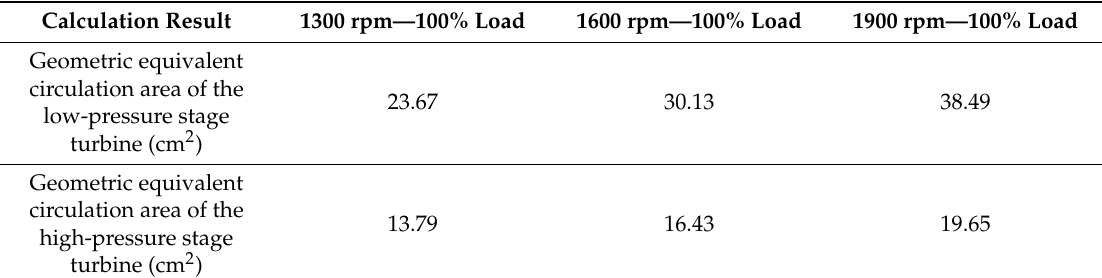
Table 4. Calculation results of turbine geometric equivalent circulation area.